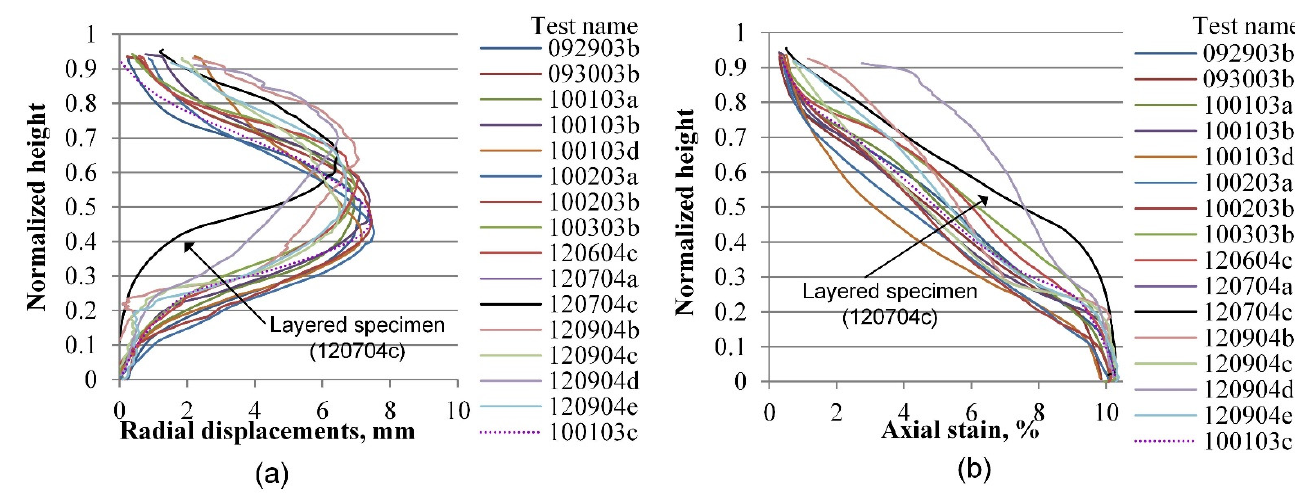
Figure 25. Vertical profiles of averaged displacements at 10.0% of the axial strain of sand specimens prepared by the vibratory compaction method: radial displacements ( a ) and vertical displacements ( b ).